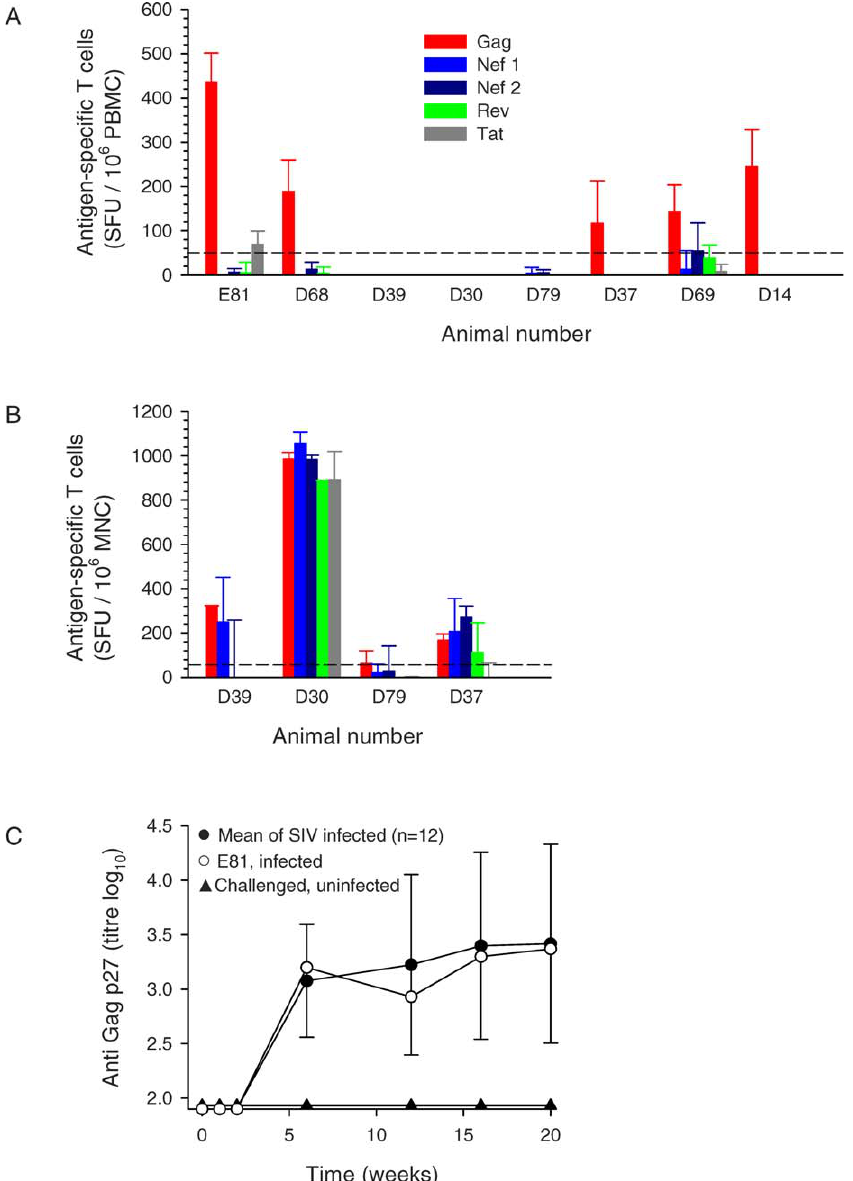
Figure 3. SIV-Specific IFN- c Secreting T Cells Were Detected in SIV-Challenged Macaques in the Absence of Serum Antibody Responses and Evidence of Overt Infection (A) IFN- c secreting T cell frequencies in PBMC from protected animals (D68–D14) compared to those in an SIV-infected animal (E81) measured 20 wk after virus exposure measured by ex vivo ELISpot. The mean frequencies of three replicate determinations plus one standard deviation are shown for each peptide pool used. (B) SIV-specific IFN- c secreting T cell frequencies in MNC isolated from ileum–jejunum tissue of four protected animals measured post mortem at 21 wk after virus challenge by ex vivo ELISpot. (C) The group mean þ / (cid:2) standard deviation profile of anti-SIV Gag p27 binding antibody titres (measured by ELISA) from animals infected with SIV ( (cid:3) ) and the individual profile for an SIV-infected macaque E81 ( * ), in which T cell ELISpot was analysed was compared with animals from which no virus